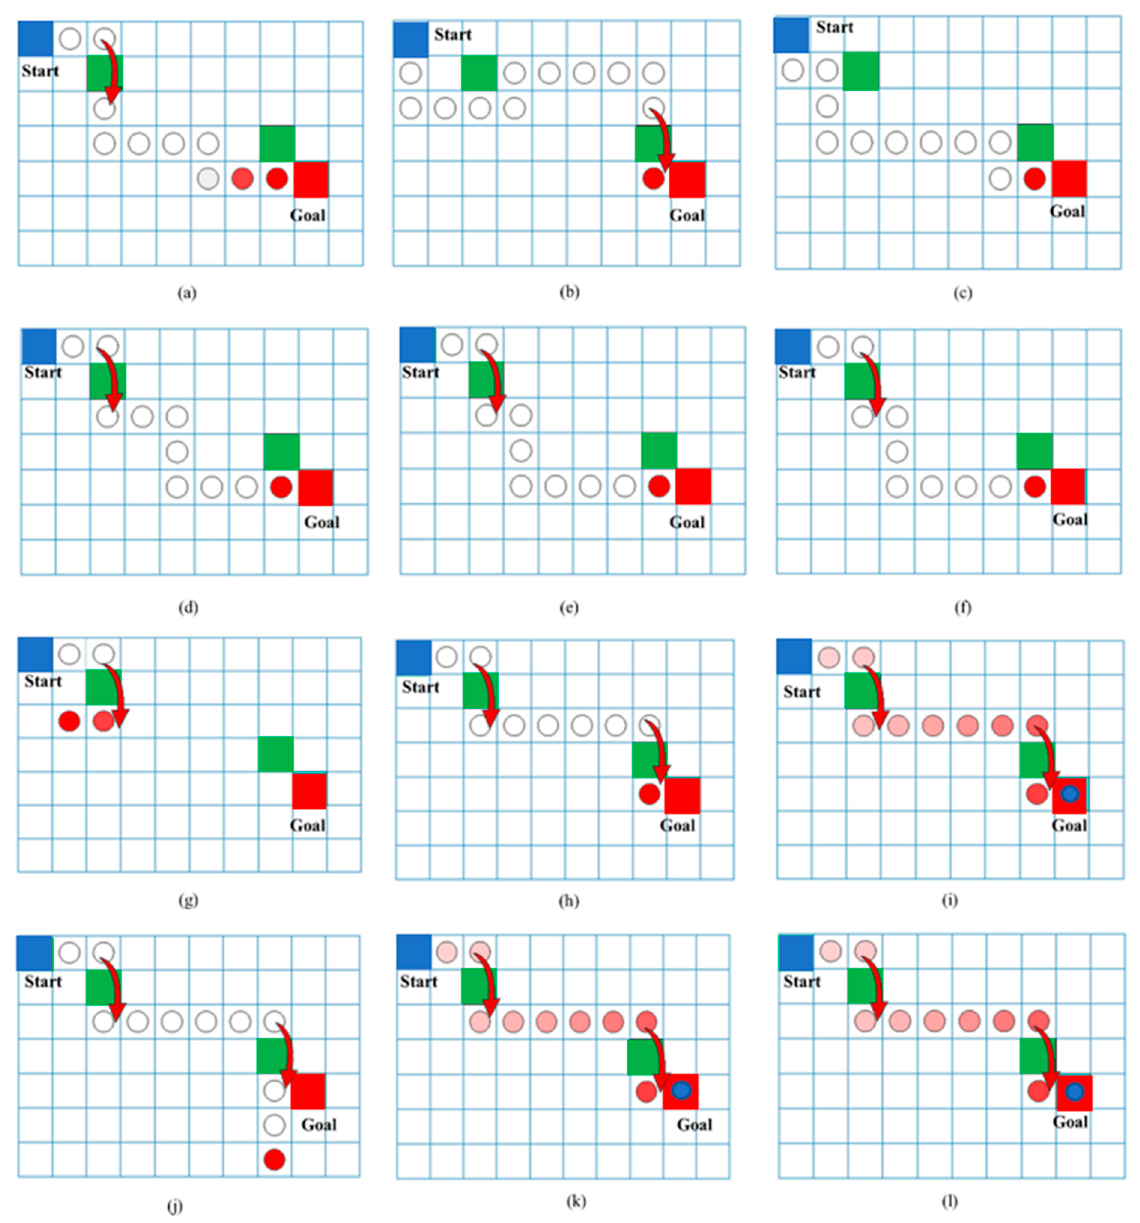
Figure 12. Path Traversed by the Agent with E = 5000 and Varying Steps Per Episode ( a – c ) Q- Learning ( d – f ) SARSA ( g – i ) DQN ( j – l ) Double DQN. Also, it can be noted that in some sub figures like ( e , f